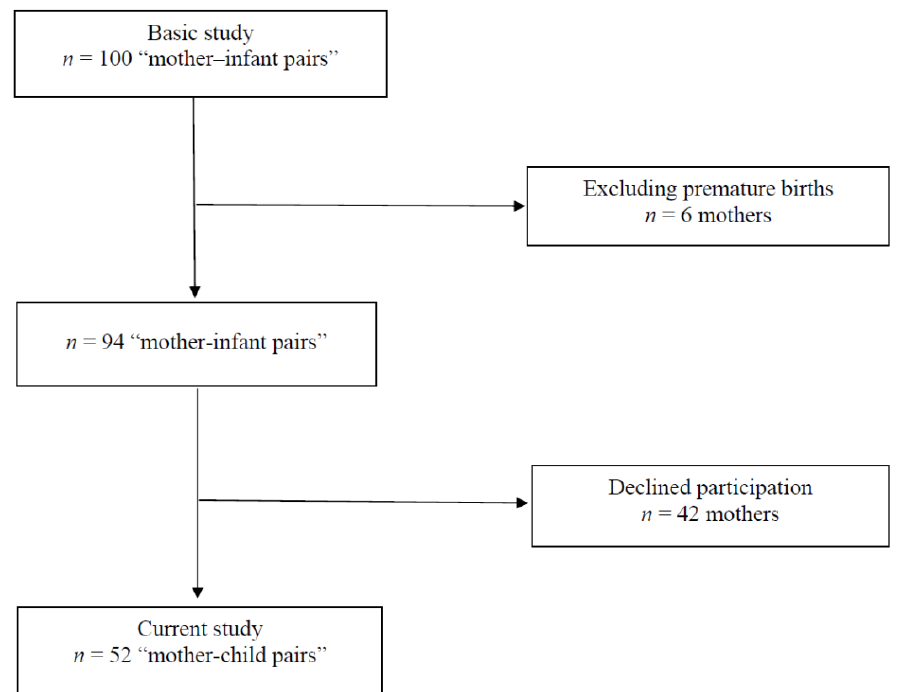
Figure 1. The process of recruiting study